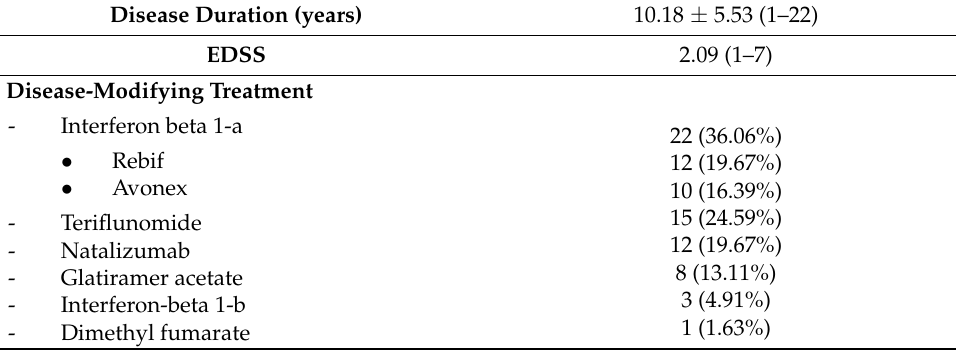
Table 2. Patient